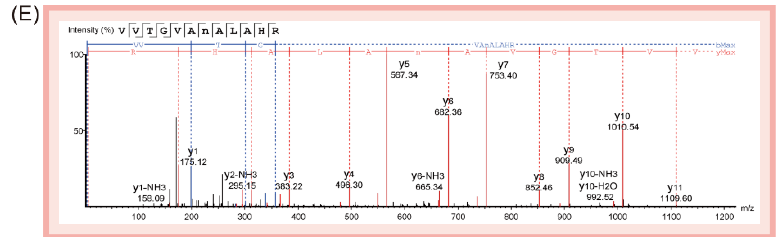
Figure 3. Corresponding sequence analysis maps (b-blue, y-red) of eight peptide biomarkers relevant to identification strategy 2. ( A ) This graph shows one common peptide biomarker except Eurasian elk: Peptide 12 (VLDAFSDGLK). ( B ) This graph shows two common peptide biomarkers except reindeer: Peptide 13 (MLTAEEK), Peptide 14 (AAVTAFWGK). ( C ) This graph shows one common peptide biomarker except white-lipped deer: Peptide 15 (LLGNVLVVVLAR). ( D ) This graph shows three common peptide biomarkers except fallow deer: Peptide 16 (HHGGEFTPVLQADFQK), Peptide 17 (AAVTGFWGK), and Peptide 18 (VLDAFSEGLK). ( E ) This graph shows one common peptide biomarker except sika deer: Peptide 19 (VVTGVANALAHR).